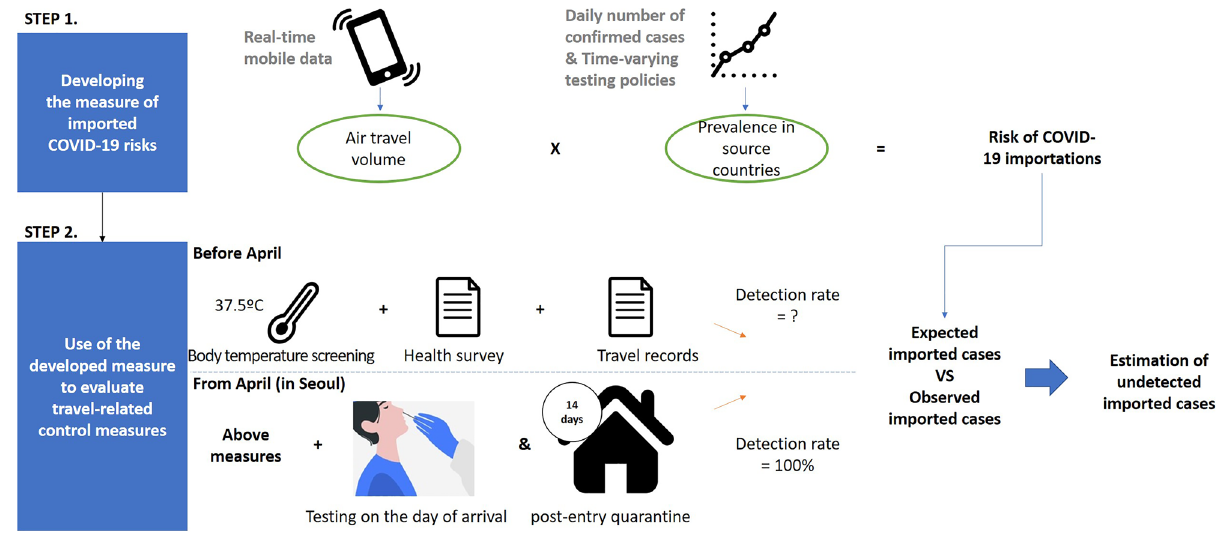
Figure 3. The methodological framework of the